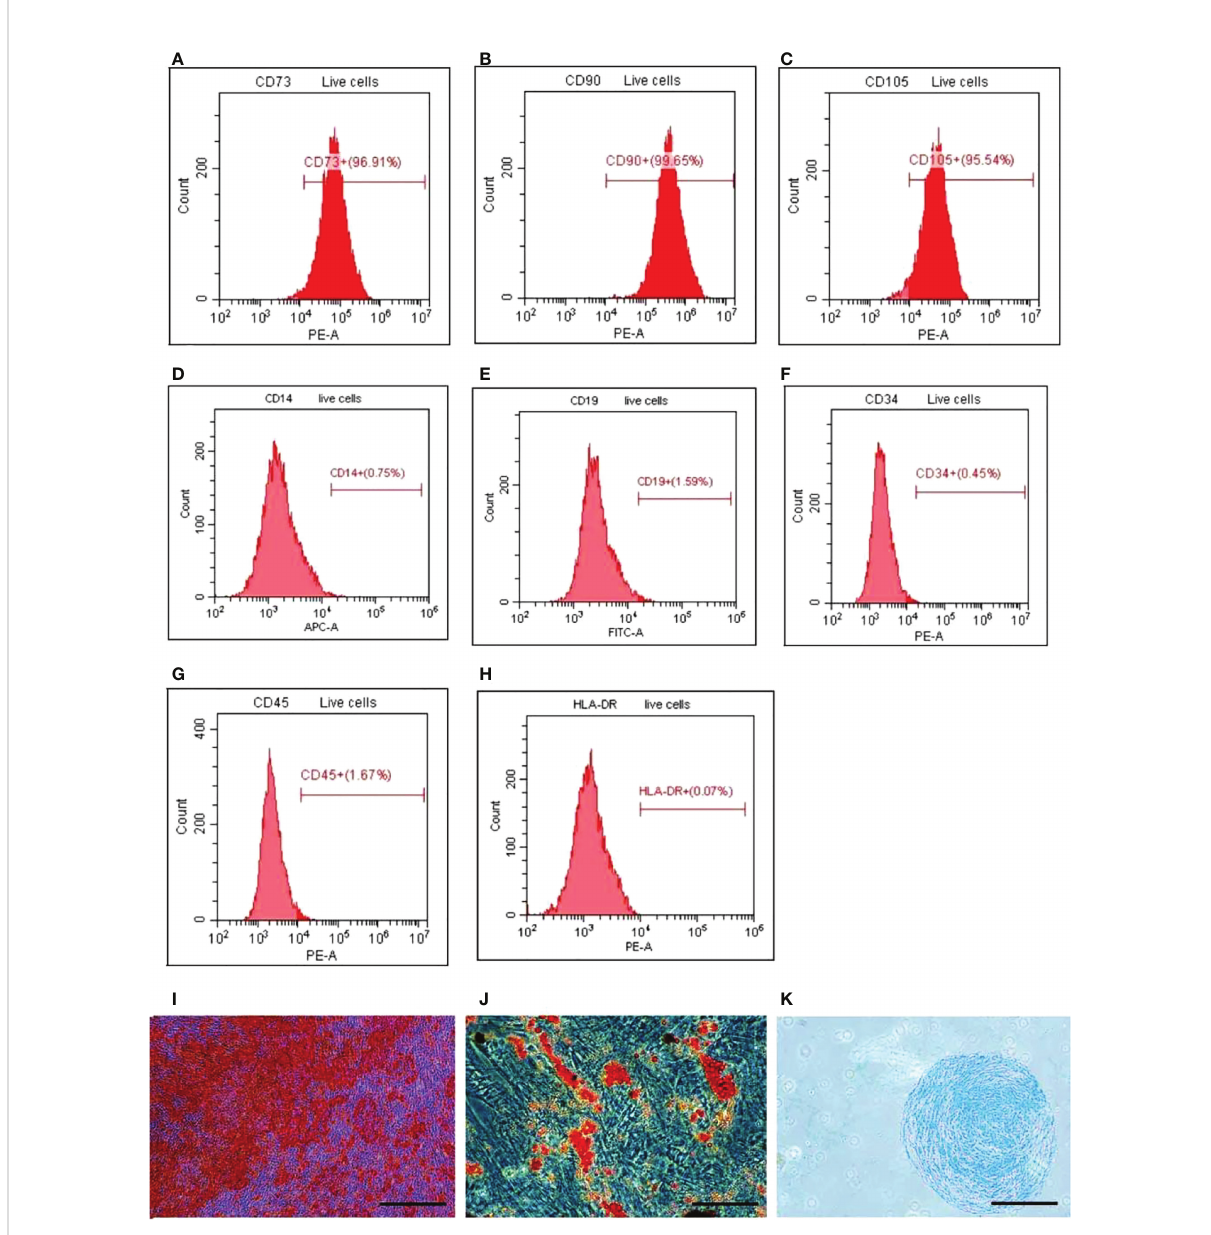
FIGURE 1 Detection of surface markers, osteogenesis, adipogenesis, and cartilage ‐ induced differentiation of HUCMSCs. FACS was used to detect the surface markers and ICC was used to detect the differentiation. (A – C) The expression of positive surface marker CD73, CD90, and CD105. (D – H) The expression of surface negative markers CD14, CD19, CD34, CD45, HLA ‐ DR. (I) The cells osteogenic differentiation was analyzed by alizarin red staining (scale bar = 20 m m). (J) The cells adipogenic differentiation was analyzed by oil red O staining (scale bar = 20 m m). (K) The cells chondrogenic differentiation was analyzed by alcian blue staining (scale bar = 100 m m). HUCMSCs, human umbilical cord mesenchymal stem